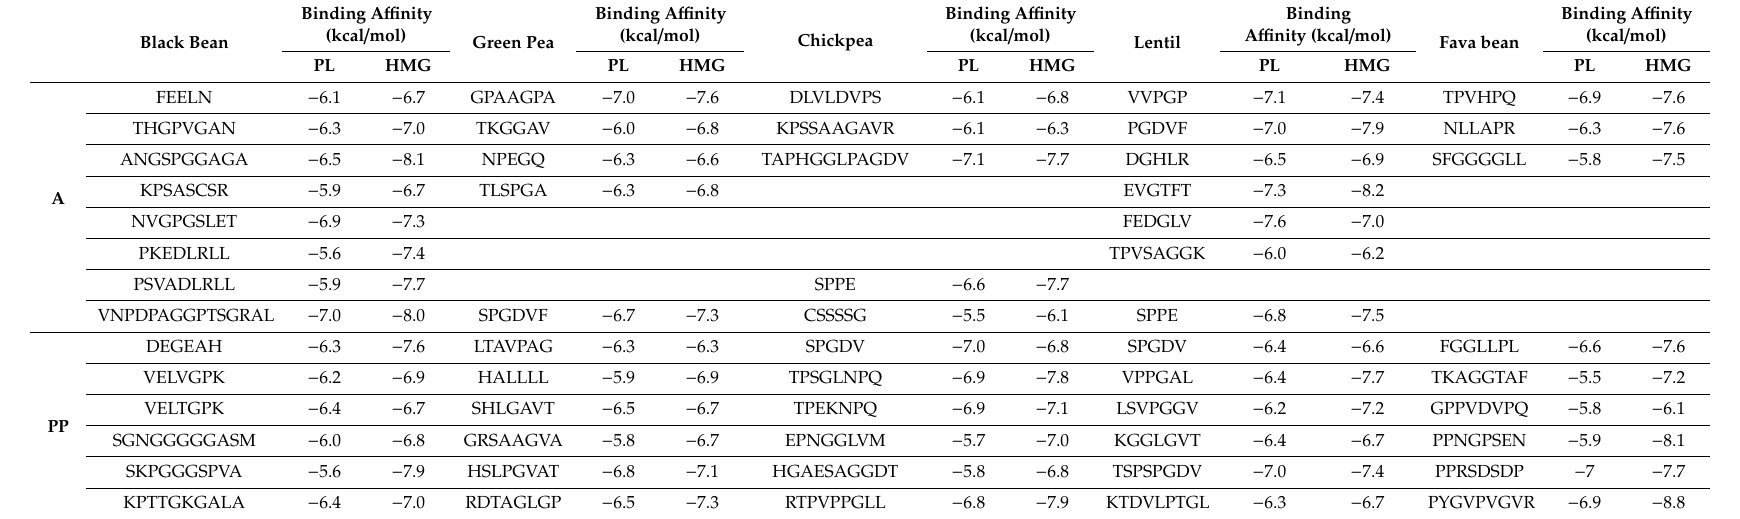
Table 2. Estimated free energy binding and chemical interactions among peptides, present in legumes hydrolyzed with alcalase and simulated gastrointestinal digestion, and the catalytic site of the pancreatic lipase and HMG-CoA